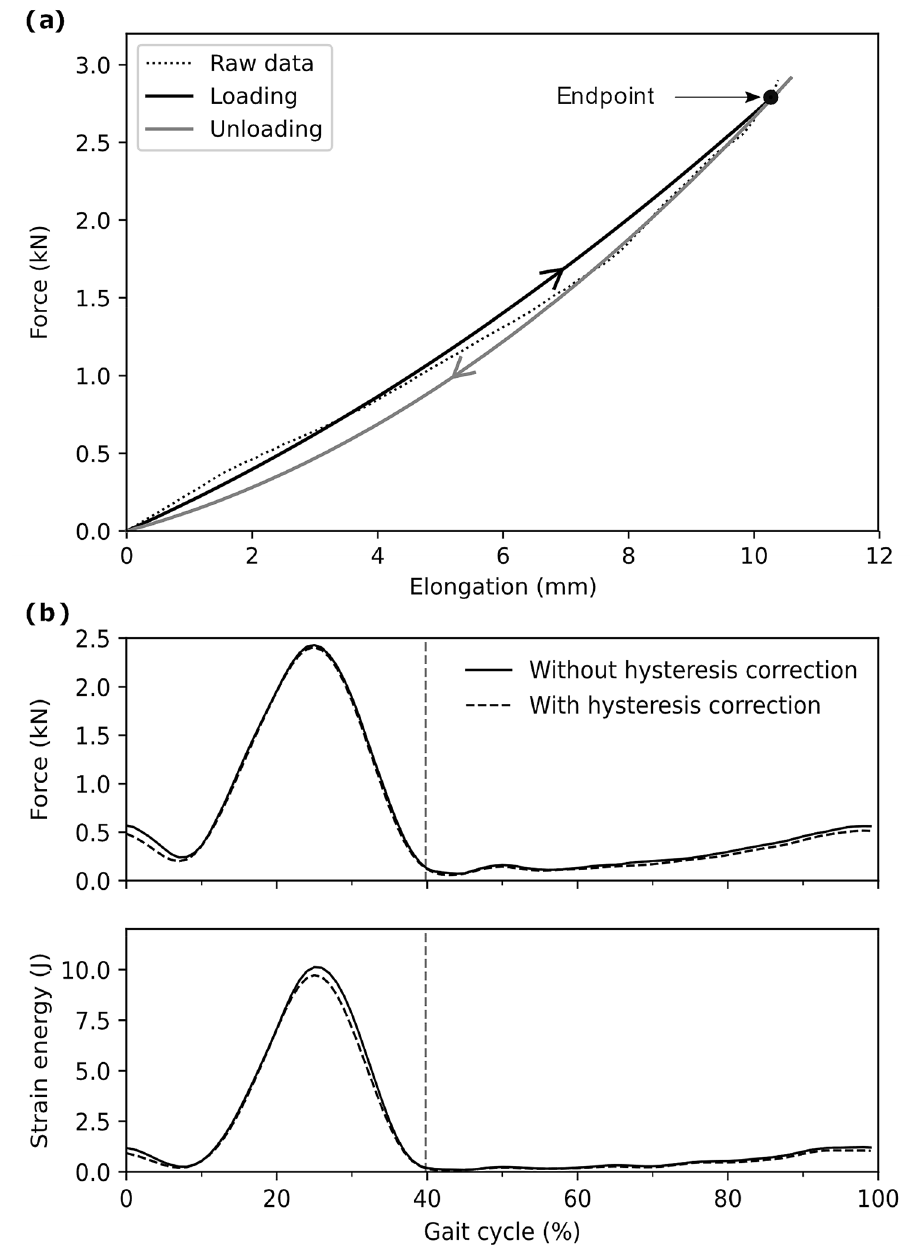
Figure 5. ( a ) Experimentally assessed Achilles tendon (AT) force–elongation relationship during maximum voluntary contractions (Raw data) and the modeled force–elongation curve during loading and unloading (eleven individuals with ten gait cycles. ( b ) AT force and AT strain energy with and without hysteresis consideration during fast (3.5 m/s) running. The x-axis is normalized to the gait cycle. The gray dashed vertical line separates the contact and swing